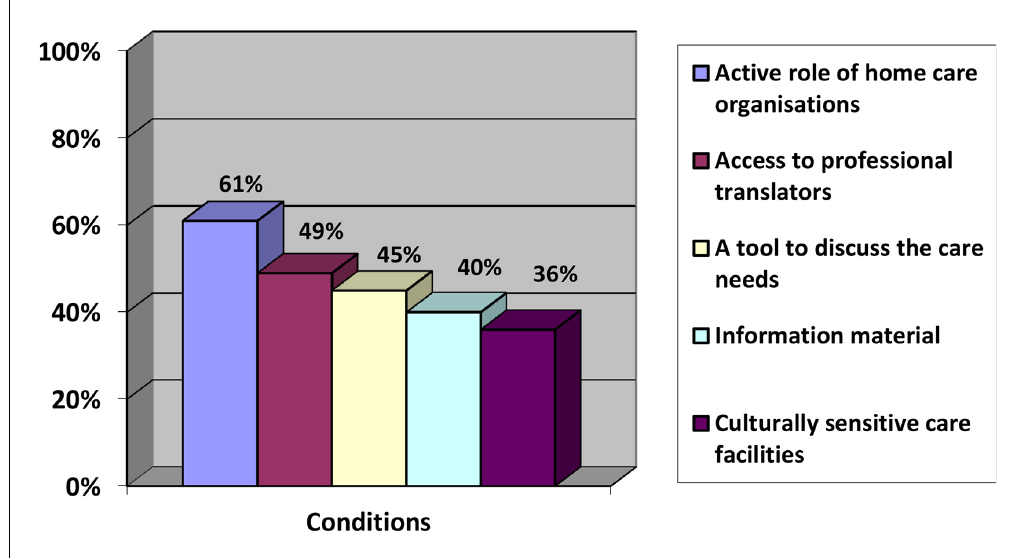
Figure 3. Conditions needed to connect with the care needs of immigrants patients with dementia and their